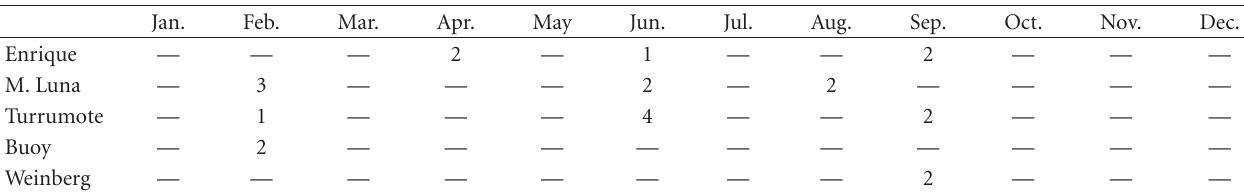
Table 2: Number of newly infected M. faveolata colonies per month in 2009 at the di ff erent reef sites. (—): no newly infected colonies. Winter included the months from January–April and summer included the months from June–September.